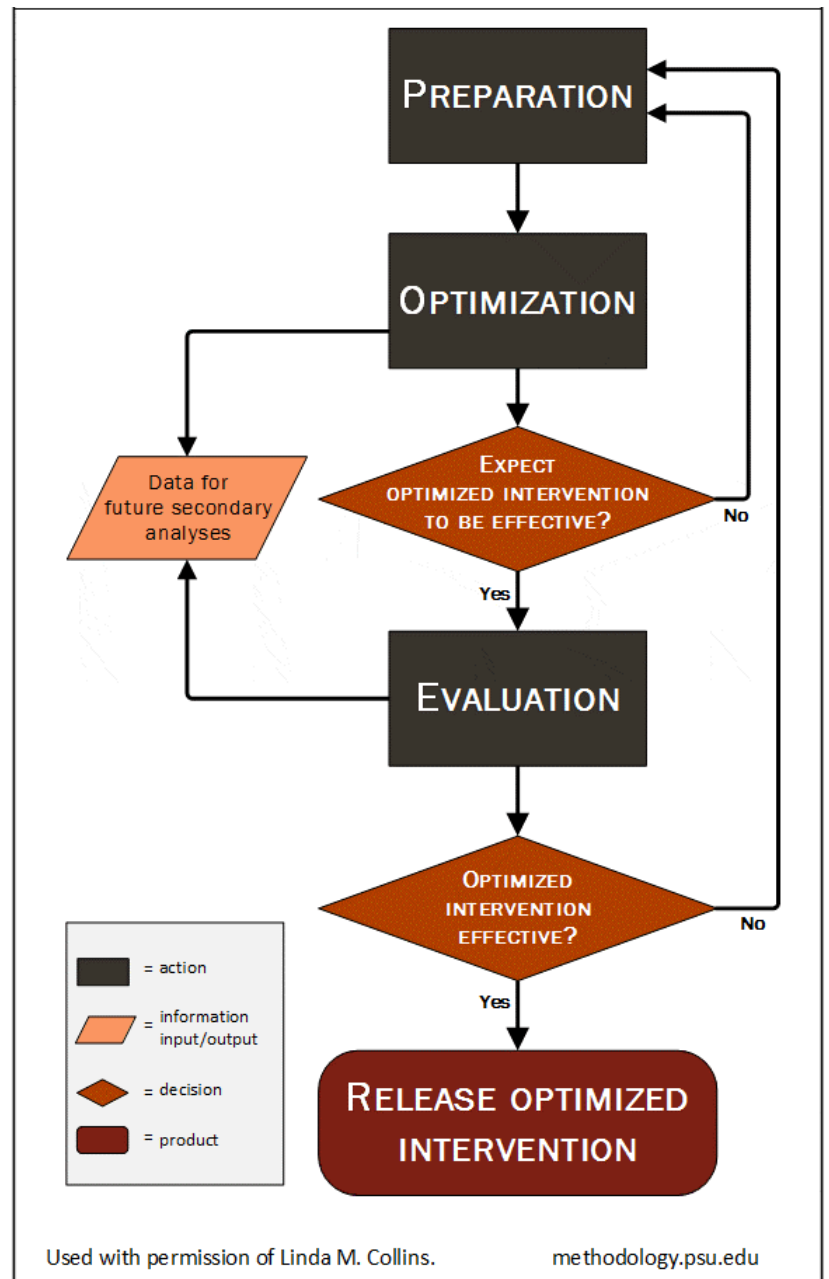
Figure 1. The multiphase optimization strategy